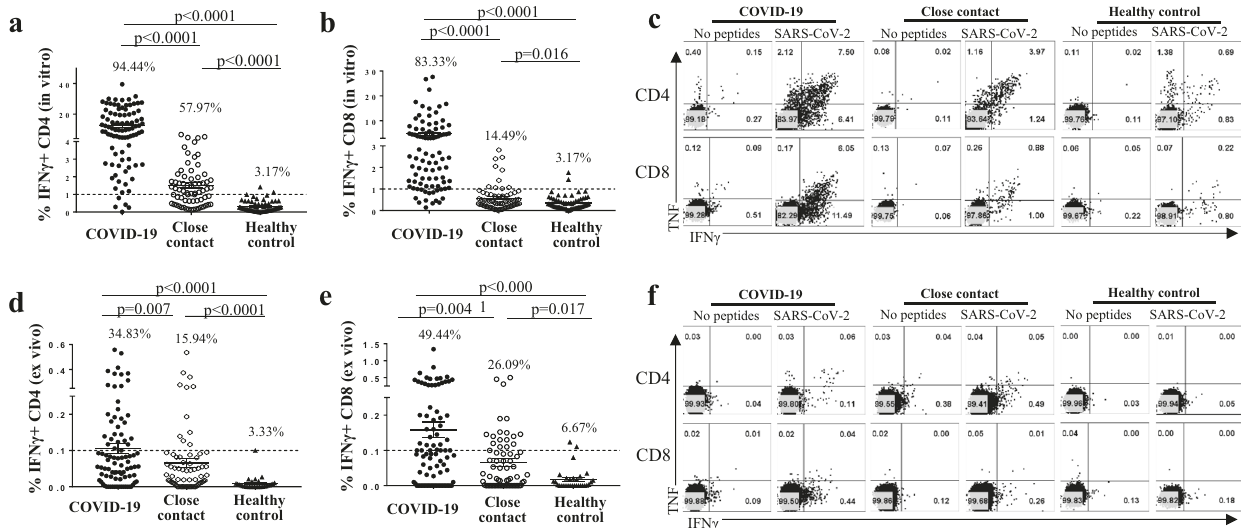
Fig. 1 Memory T cells speci fi c to SARS-2 were detected and can proliferate in vitro in COVID-19 patients and in close contacts. Donor PBMCs were stimulated with 15-mer peptide pools (overlapping by 11 amino acids) encompassing the entire spike (S), nucleocapsid (N), membrane (M), and envelope (E) proteins for 10 days (in vitro expansion, a – c ) or overnight (ex vivo, d – f ) in the presence of 10 U/ml rIL-2, IFN γ , and TNF expressing cells were enumerated by intracellular cytokine staining. Ninety COVID-19 patients (closed circle), their 69 close contacts (open circle), and 63 unexposed healthy donors (closed triangle) were assayed in vitro. For ex vivo experiments, the samples from the above cohort except for one from the COVID-19 group because of cells used up, and 30 of the 63 unexposed healthy donors were assayed. Graphs show the frequency of IFN γ expressing cells in ( a ) CD4 + and ( b ) CD8 + T cells after in vitro expansion and overnight stimulation and in ( d ) CD4 + and ( e ) CD8 + T cells after overnight stimulation. Dashed line is the cut off determined by the background staining (no peptide) for the healthy control group. The cut off threshold used for the overnight stimulation experiments was based on all negative controls (95% CI). The percentages shown are the frequency above this cut off. c , f Representative dot plots showing IFN γ and TNF expression in T cells after expansion ( c ) or overnight stimulation ( f ). a , b , d , e Error bars indicate mean frequencies of IFN γ + T cells ± SEM; Percentage shown on top of the plots indicates the frequencies of samples above the cutoff. The student t test was performed with two-sided p values as indicated. No peptides: no peptide stimulation control. SARS-CoV-2: with stimulation by SARS-CoV-2 overlapping peptide virus-speci fi c T cells (34.83% for CD4 + , Fig. 1d; 49.44% for CD8 + , Fig. 1e; and cut off = 0.1%) at 48 – 86 days after disease onset. In addition, SARS-CoV-2-speci fi c T cells were also detec-